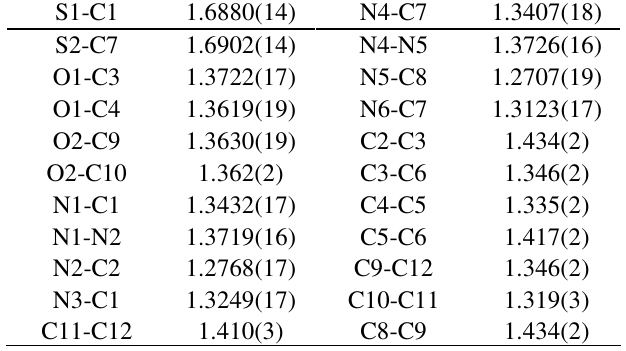
Table 3. Selected bond distances (Å) for the title